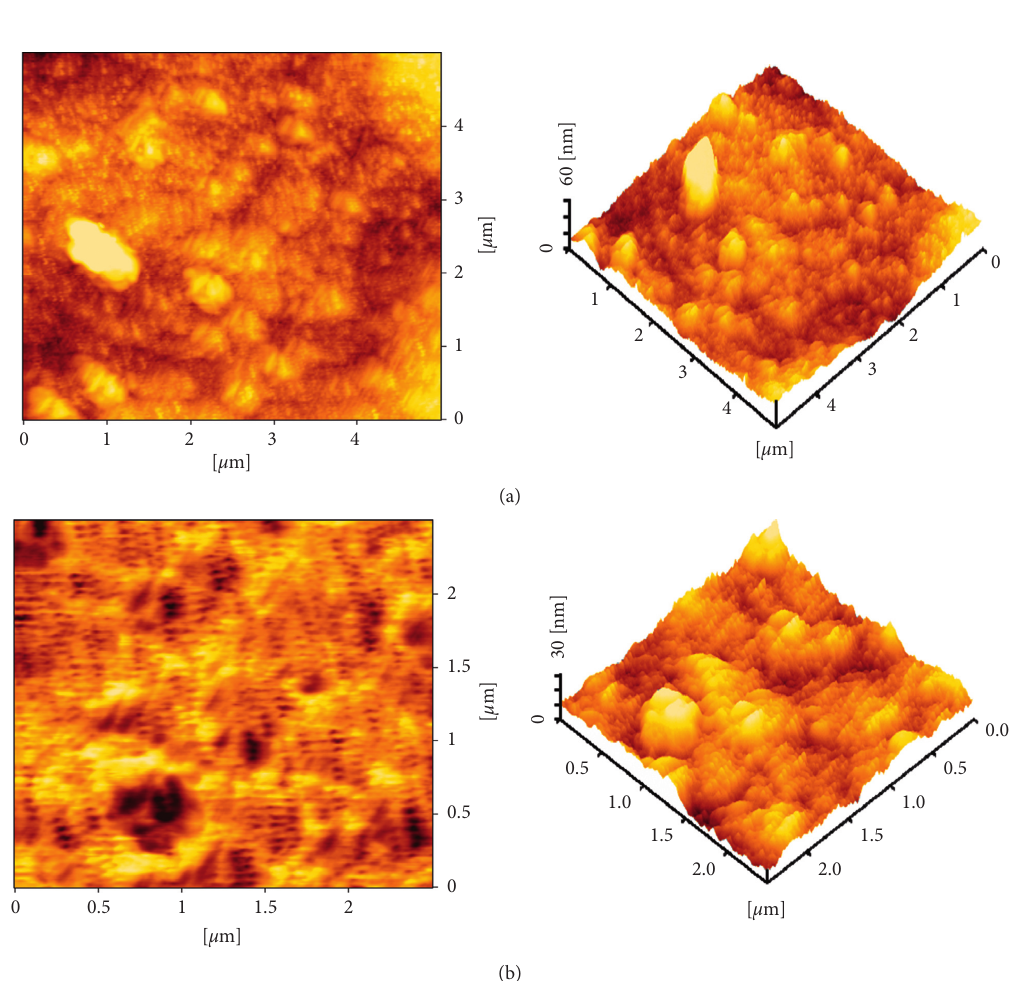
Figure 7: AFM topographies with 3D structure of SnO temperatures.